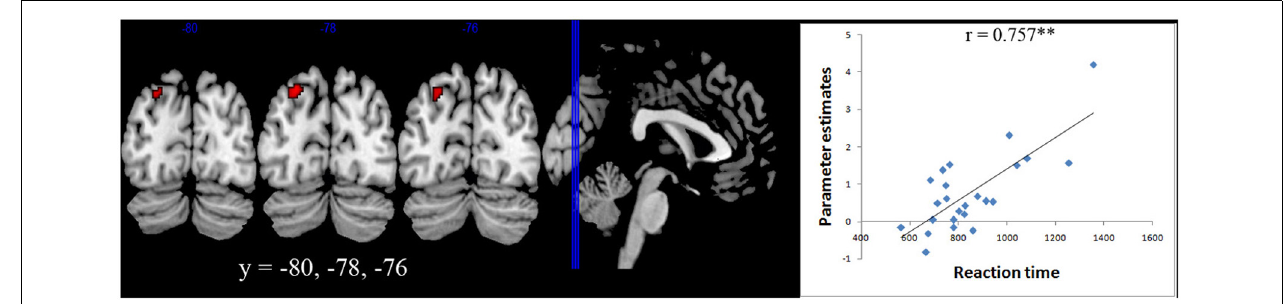
FIGURE 5 | Brain-behavior correlation. Whole brain regression analysis with reaction time for Nagari task showed a significant correlation ( p < 0 . 05 FDR) with activation in Left IPS centered at ( − 24 − 78